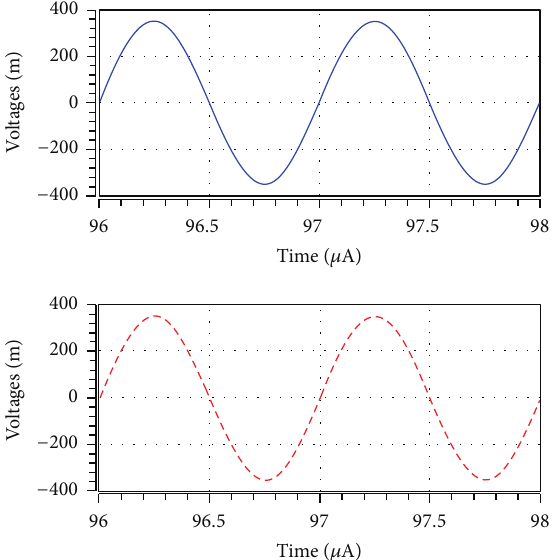
Figure 13: The input (blue line) and output (red line) waveforms of noninverting bandpass filter at 𝑉 𝑜1 designed with 𝑅 1 = 𝑅 2 = 𝑅 3 = = 10 k Ω , 𝐶 = 𝐶 = 15.9 pF, for a 1MHz sinusoidal input voltage 𝑅 4 1 2 of 0.7 V (peak to peak).